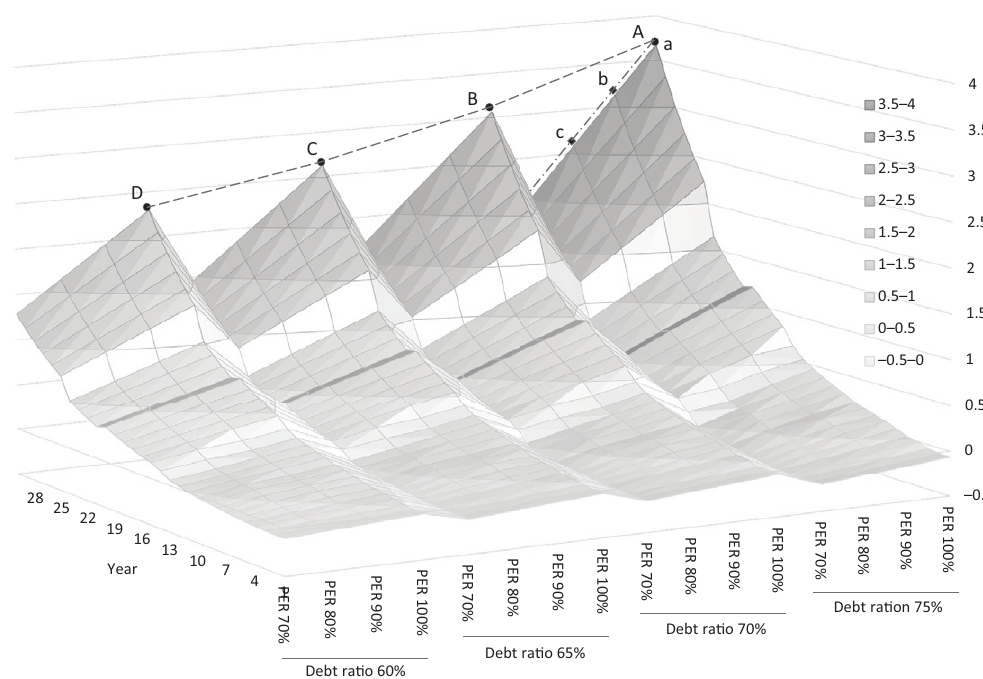
Figure 12. Simulation results for ROE influenced by different financing strategies